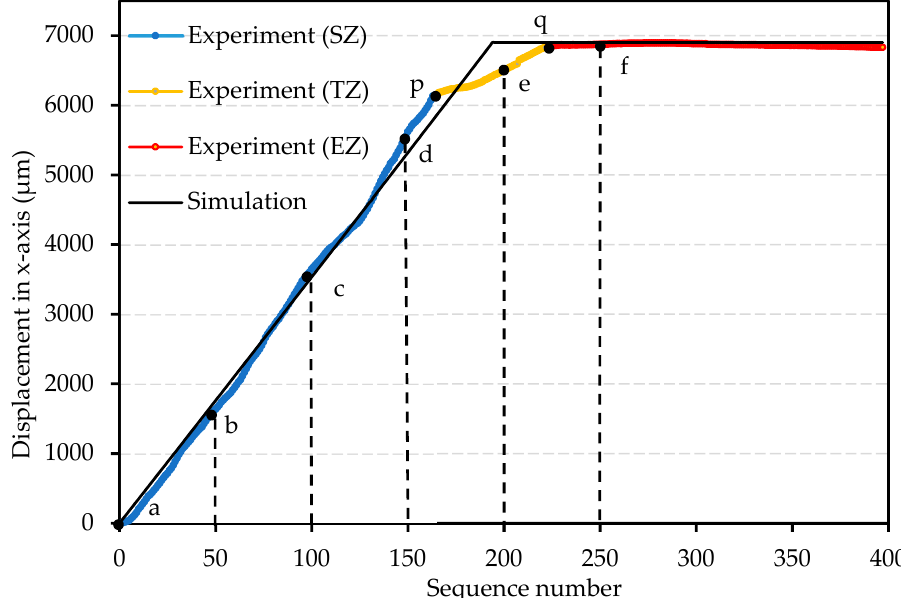
Figure 12. Normal distribution of Δ X.